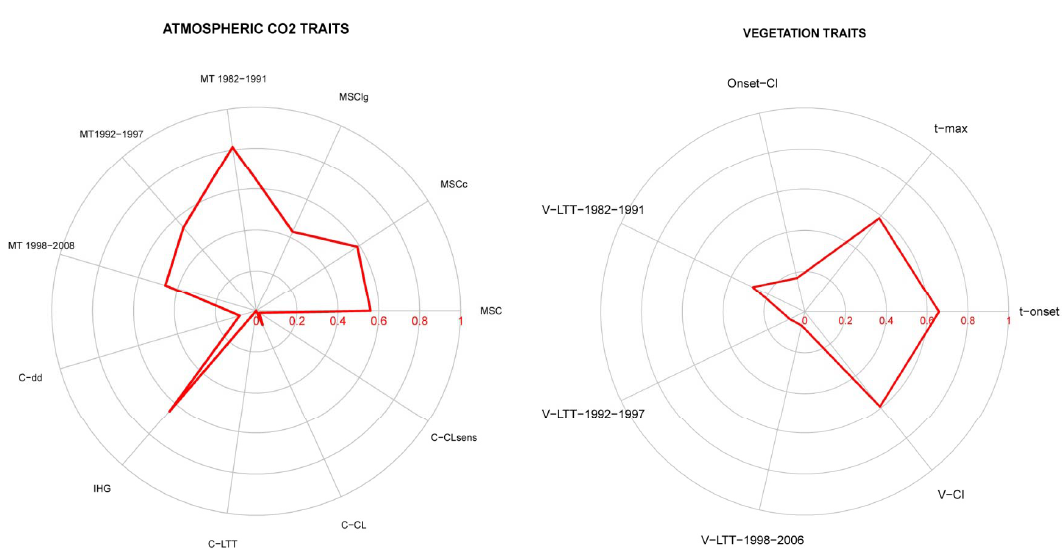
Fig. 2. Global atmospheric CO 2 and vegetation activity scores for the JSBACH model according to the list of traits in Tables 2 and 3. The polar plot goes radially from 0 (less skillful model), in the centre, to 1 (skillful). Since we only consider one model here, we refer to the threshold value of 0.5 to indicate the model good/high performances and less good/low